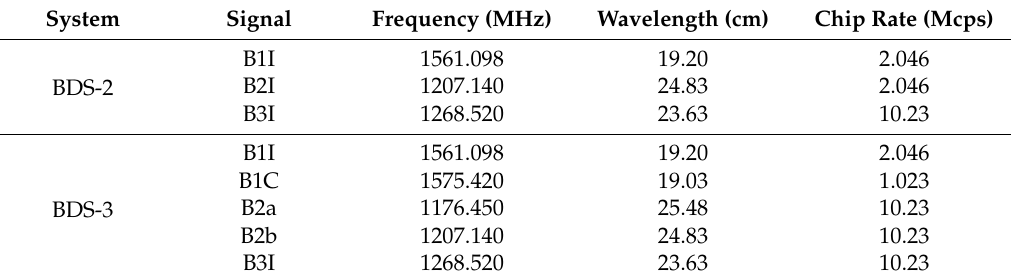
Table 2. Open service signals of BDS-2 and